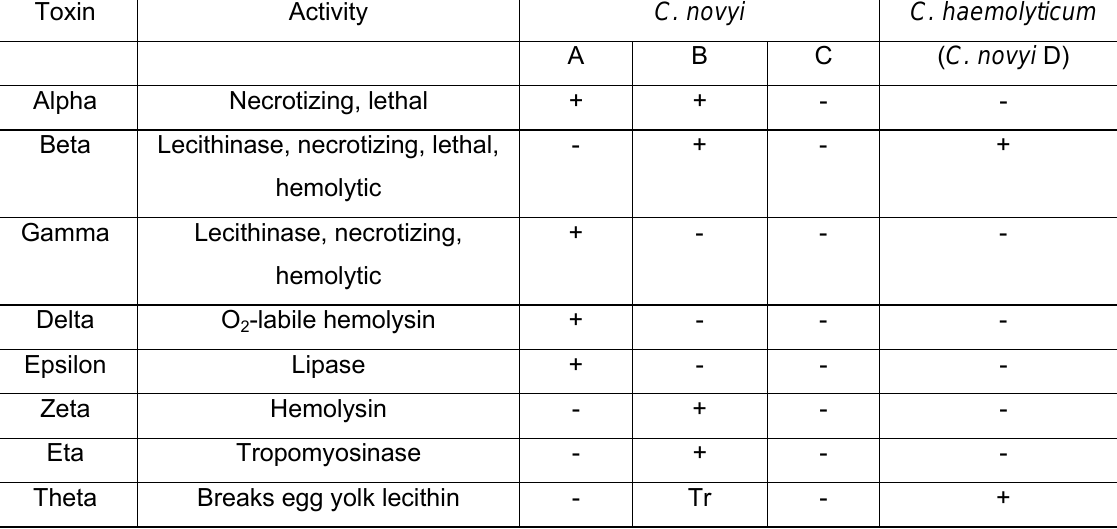
Table 2: C. novyi and C. haemolyticum toxins and their activities (28).